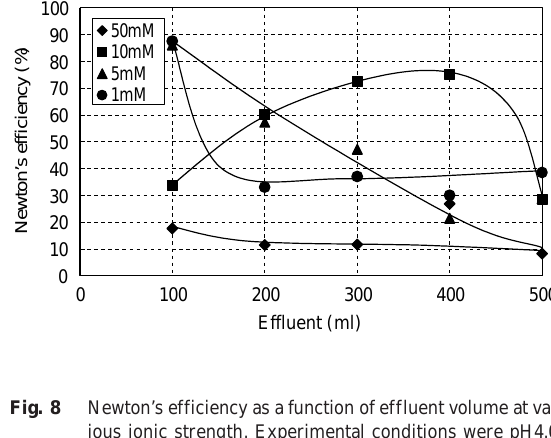
Newton’s efficiency as a function of effluent volume at var- ious ionic strength. Experimental conditions were pH4.0, silica concentration of 26mg/L, and superficial velocity of